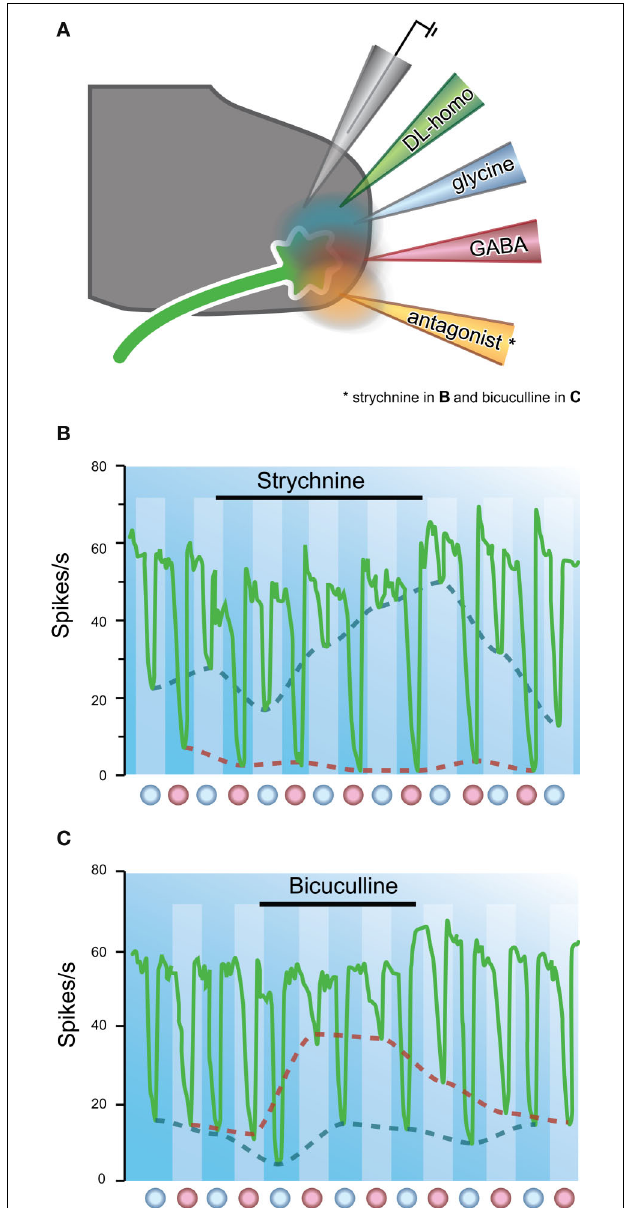
FIGURE 6 | The major inhibitory neurotransmitters can be distinguished pharmacologically. (A) Neurons are activated by continuous iontophoretic application of DL-homocysteic acid. Putative neurotransmitters and their antagonists, strychnine or bicuculline, are delivered via adjacent barrels in a multi-barrel electrode array. (B) Plot showing the effect of strychnine on inhibition of a Renshaw cell by applied glycine and GABA. Sustained iontophoresis of DL-homocysteic acid maintains a constant discharge rate in the target neuron. Glycine and GABA are alternatively applied at times indicated by red and blue dots, respectively. Strychnine application is indicated by horizontal bar. Note strychnine has a marked effect on glycine, but not GABA-mediated inhibition (red vs. blue dashed lines). (C) Similar experiment to (B) , but strychnine application replaced by bicuculline. Note, bicuculline has a marked effect on GABA, but not glycine-mediated inhibition (blue vs. red dashed lines). These experiments showed strychnine and bicuculline could be used to distinguish glycine and GABA-mediated synaptic transmission. Modifi ed with permission from Curtis et al.